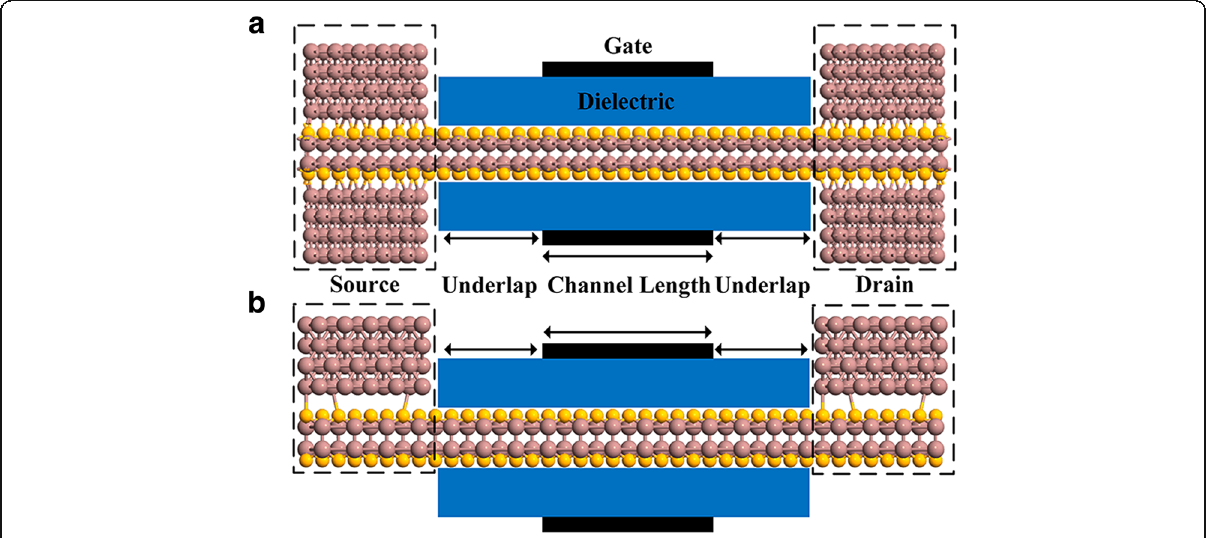
Fig. 3 Geometries of InSe FETs with sandwiched ( a ) and top ( b )